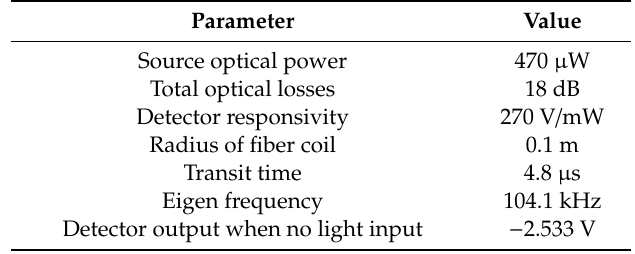
Table 1. Parameters of interferometric fiber optic gyroscope (IFOG).